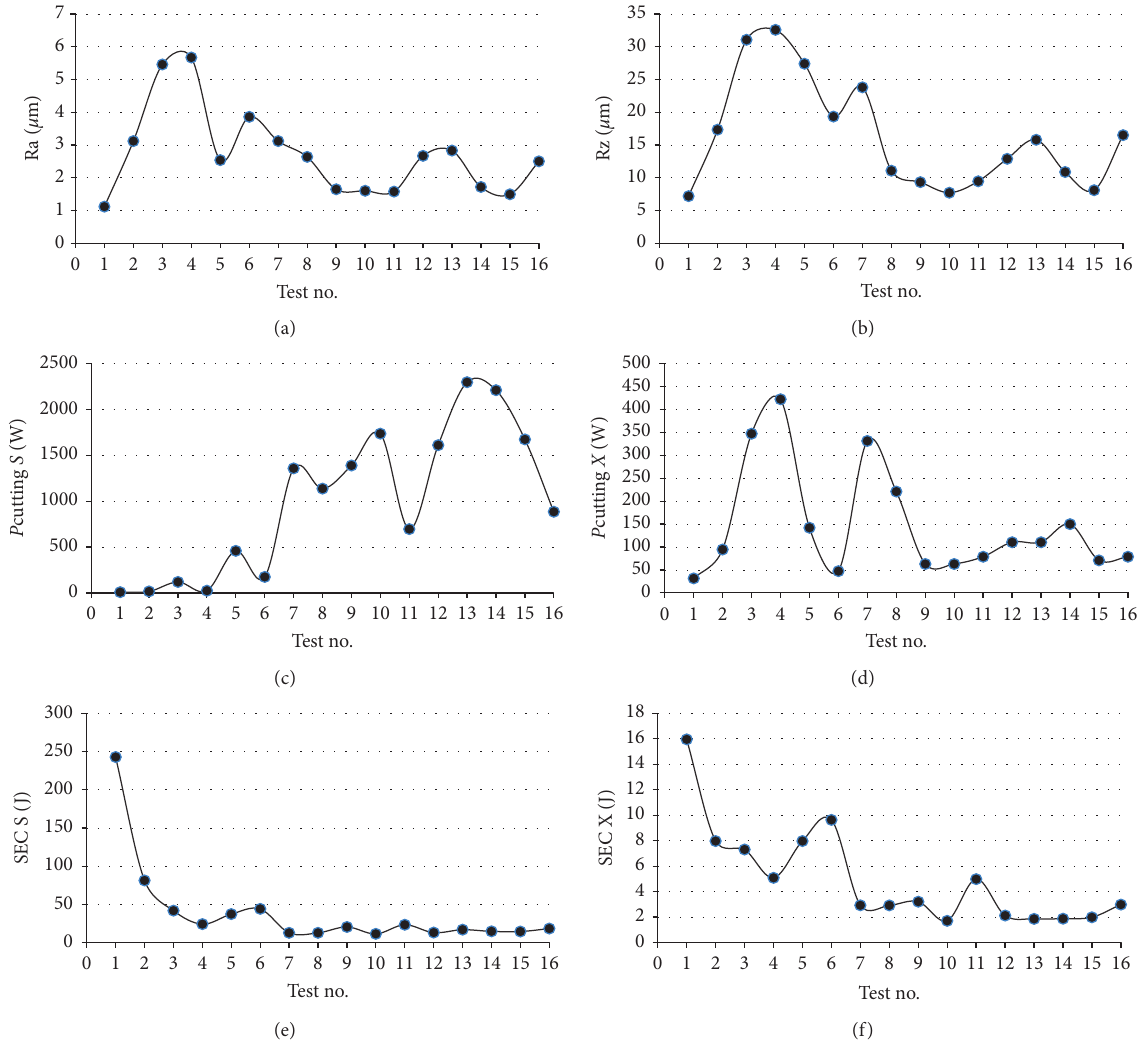
Figure 2: Experimental results for surface roughness and energy